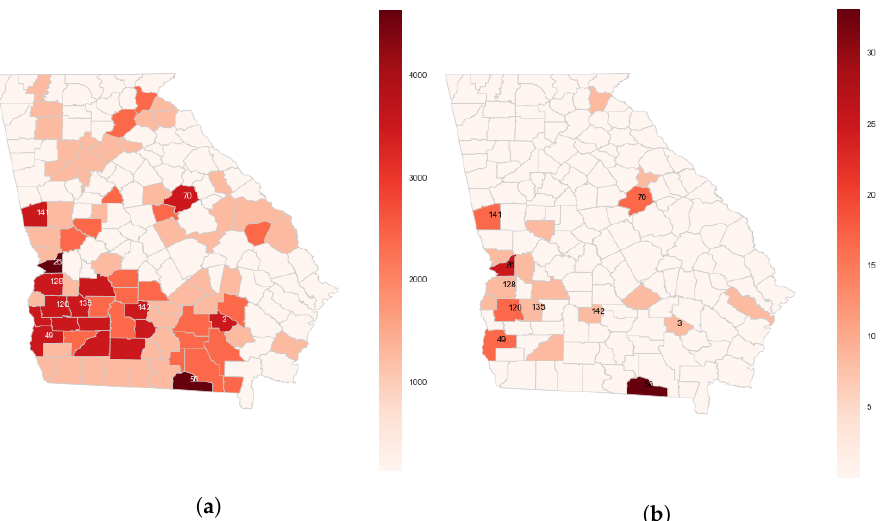
Figure 11. Choropleth map of ( a ) number of COVID-19 cases ( b ) squared spatial studentized predic- tion residual, showing outliers in the Georgia counties as detected by the